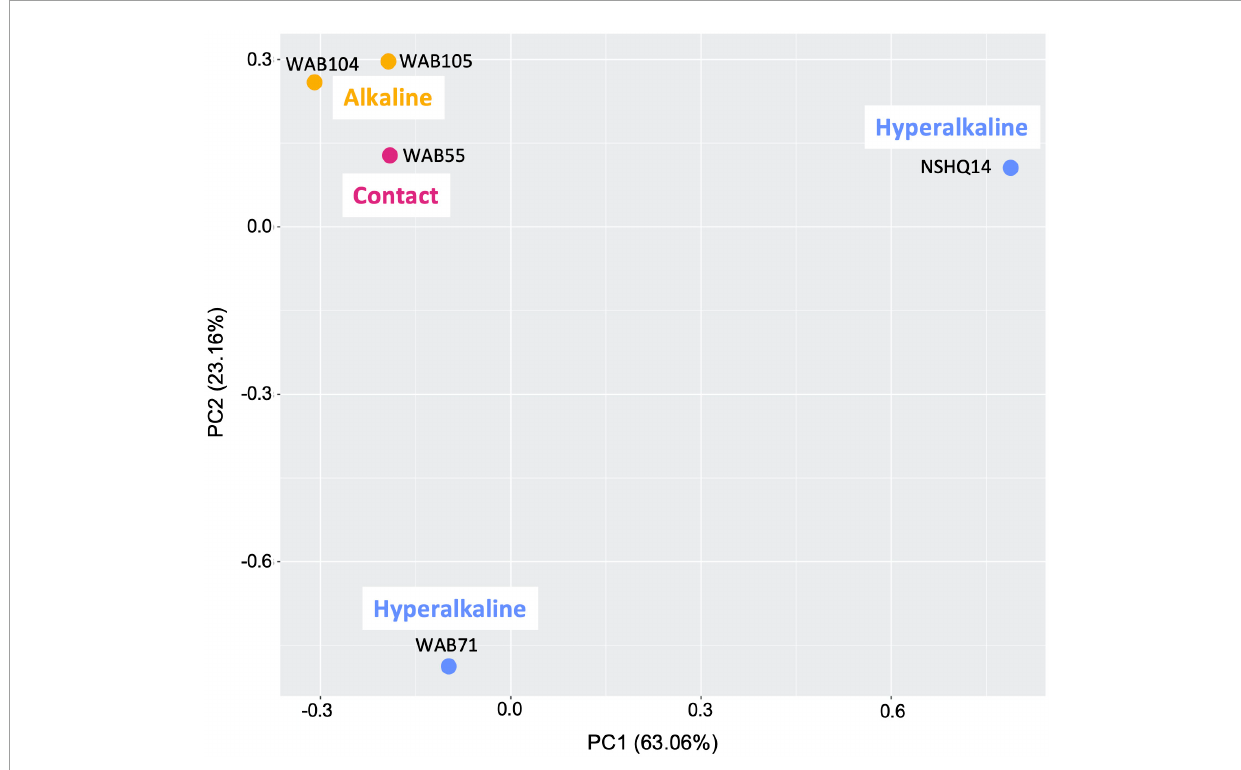
FIGURE1 Principal component analysis comparing metabolomes of five sampled wells and blanks. The gray area is a cloud of all metabolomic features across all